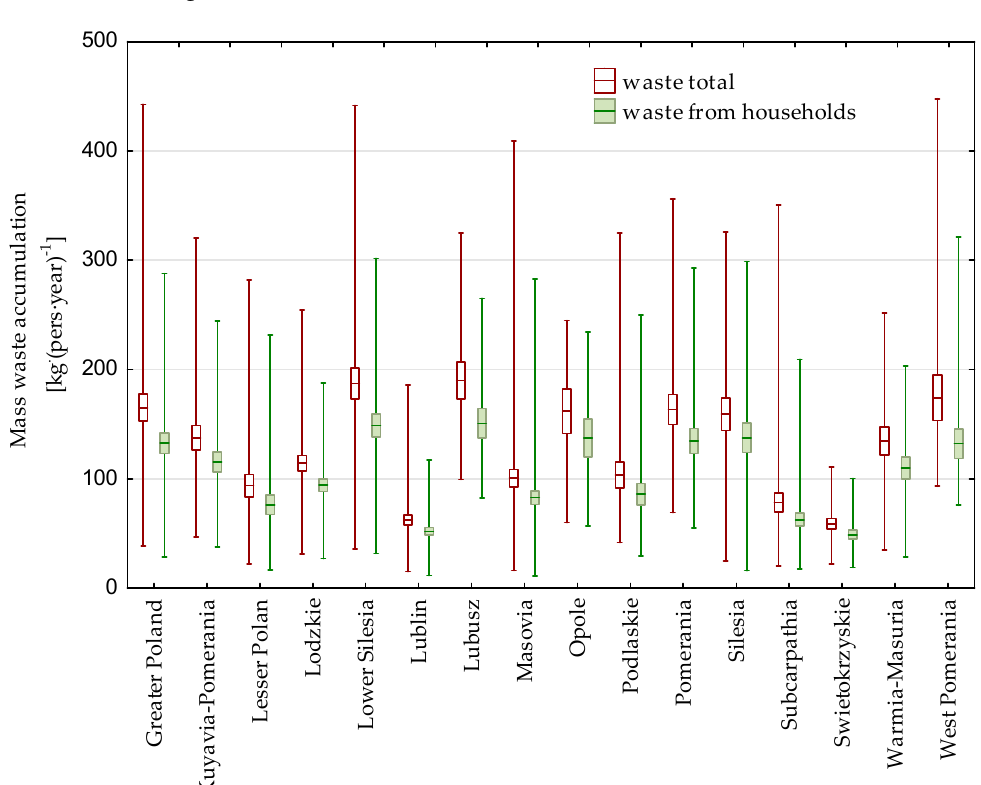
Figure 4. Mass waste accumulation for administrative rural municipalities.